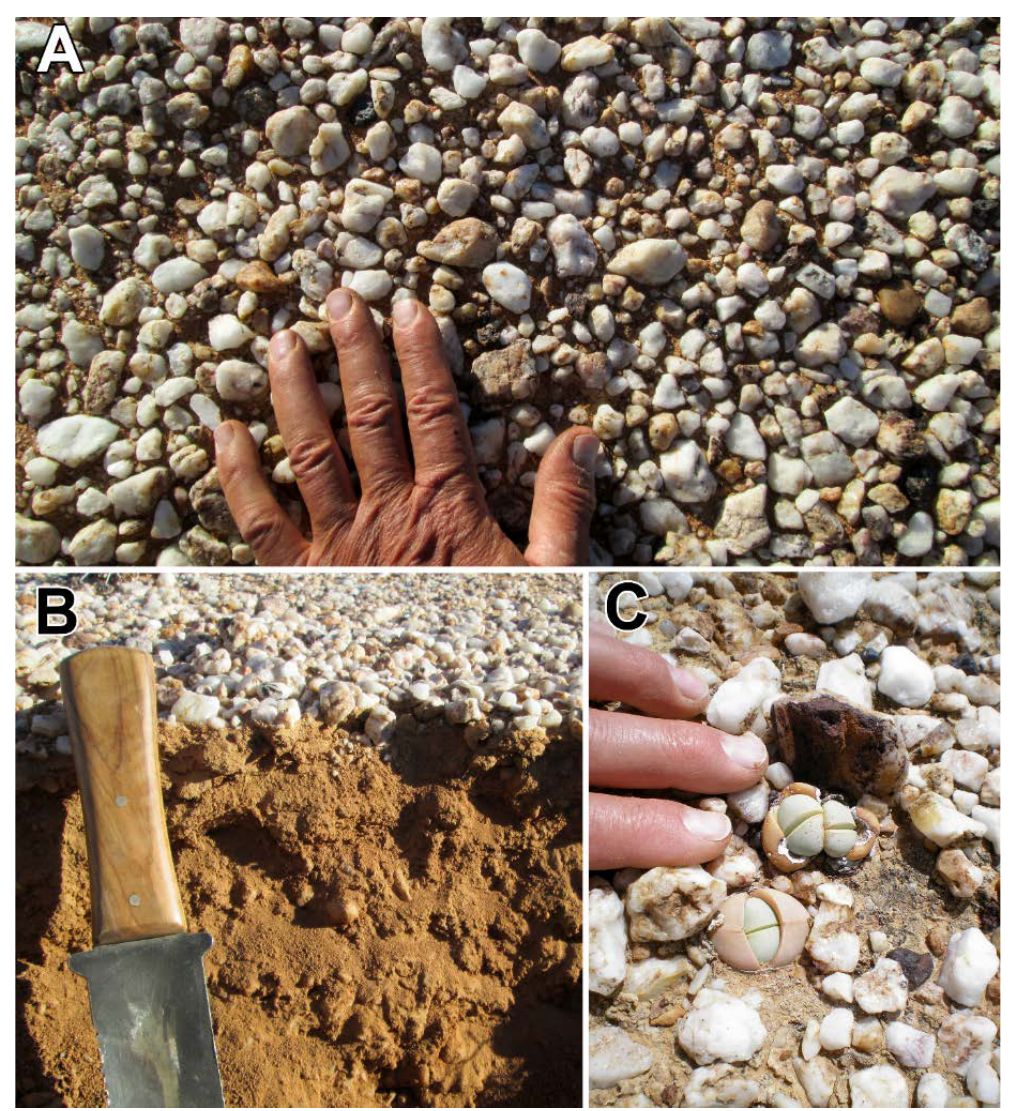
Figure 10. ( A ) Vertical view of quartz pavement; ( B ) Vertical profile through upper portion of the same pavement. The fine-grained, silt-rich soil contains very little gravel; ( C ) Fully-developed specimens of a microsucculent plant species ( Argyroderma delaetii , family Aizoaeceae) growing amidst clasts on a quartz pavement. This species has an amusing common name in Afrikaans— bababoudtjies —“baby bums”.